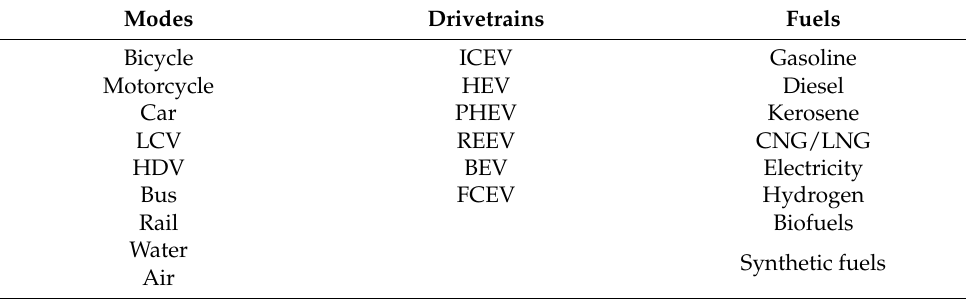
Table 1. Considered modes, drivetrains, and fuels for